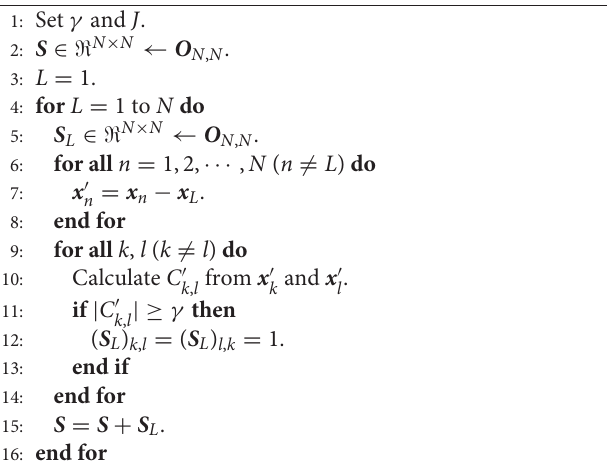
used for building an affinity graph expressing the correlation-